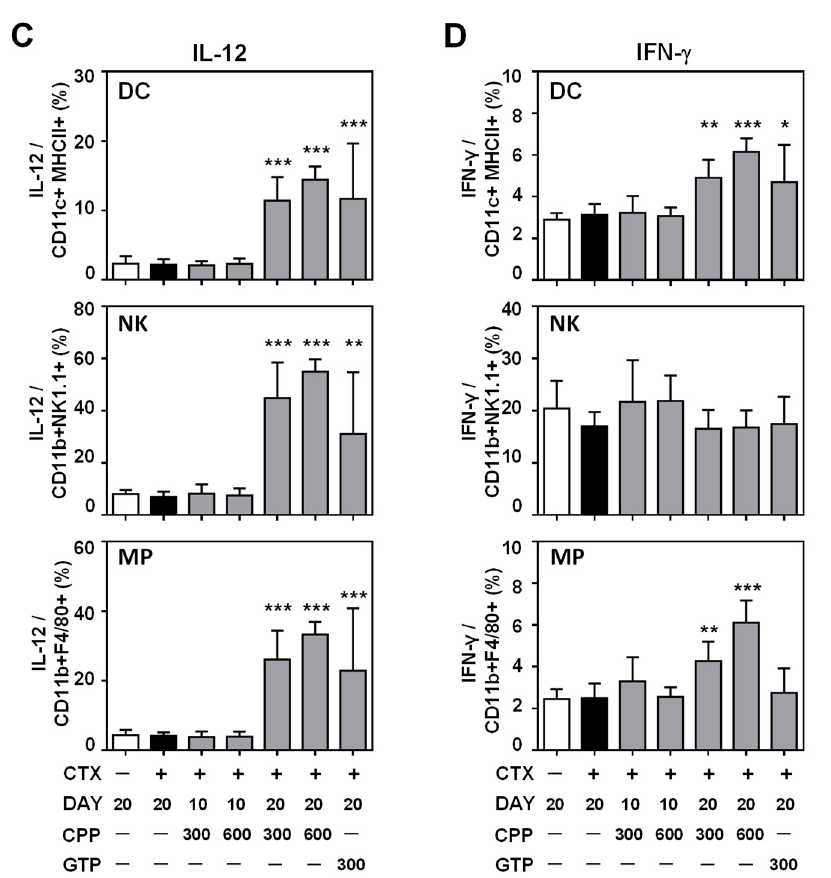
Figure 3. CPP treatment increased the frequency of IL-12 + innate immune cells. ( A ) Schematic diagram of ex vivo experiment. Mice were treated as describe in Figure 2, and the harvested splenocytes were isolated, stimulated with LPS for 6 h, and subjected to cell staining and flow cytometry ( n = 8). ( B ) Representative flow chart of the CTX-treated samples with or without CPP. Flow cytometry of ( C ) IL-12 + or ( D ) IFN γ + cells in the following cell populations: dendritic cell-enriched CD11c + MHCII + (DC), NK cell-enriched (NK), and macrophage-enriched CD11b + F4 / 80 + (MP). Mouse splenocytes